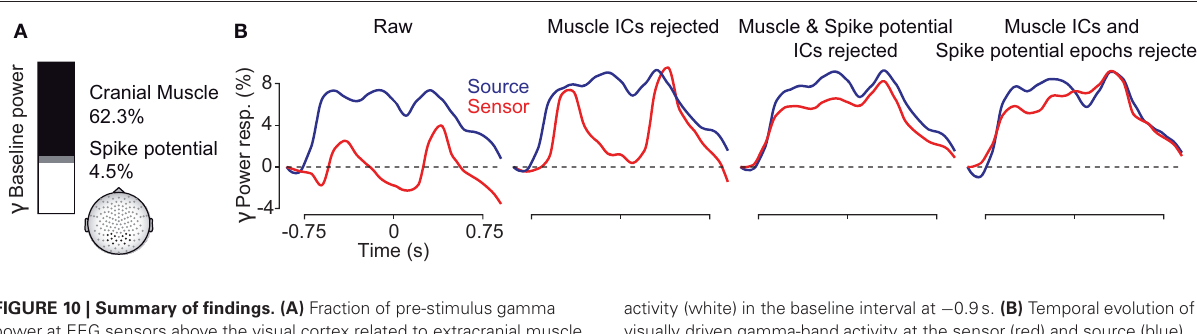
activity (white) in the baseline interval at − 0.9s. (B) Temporal evolution of visually driven gamma-band activity at the sensor (red) and source (blue) level. The four plots show the signals at different stages of artifact